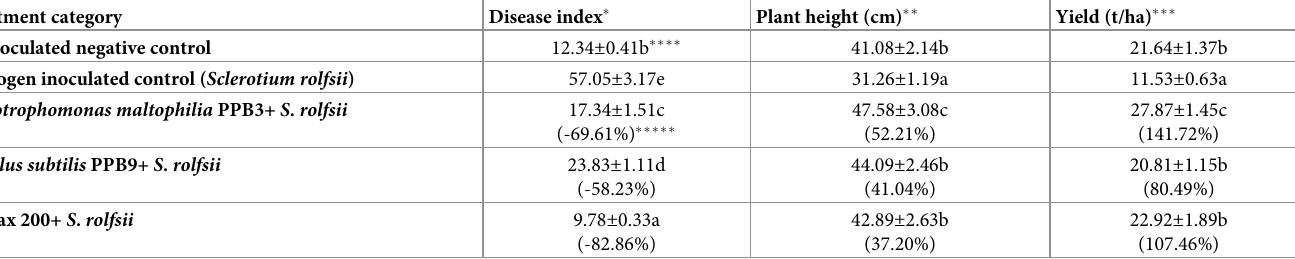
Table 5. Effect of rhizobacterial treatments on disease severity and yield-contributing parameters in Sclerotium rolfsii -inoculated tomato cv. Minto Super F1 in the field.